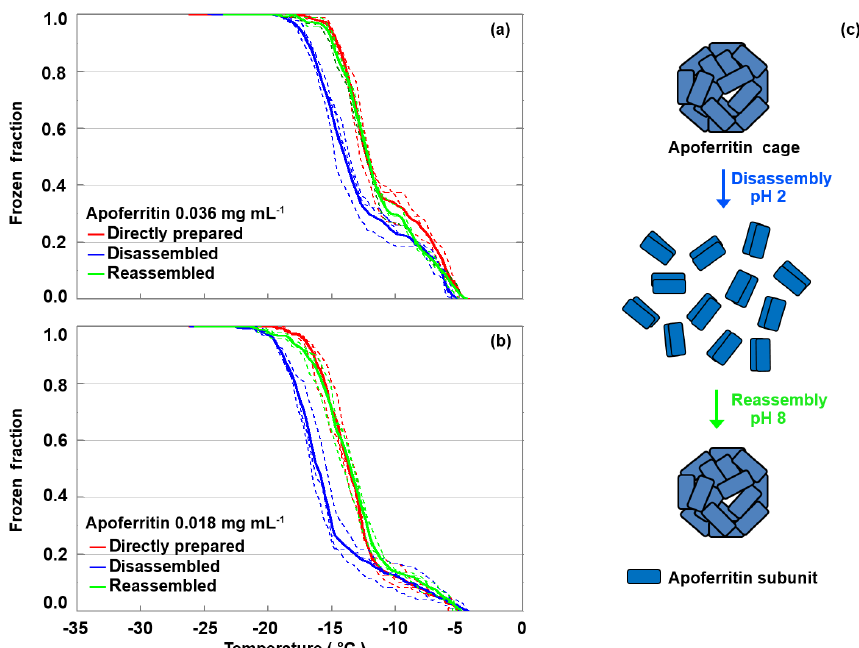
Figure 9. Disassembly and reassembly experiment performed with apoferritin (batch 2) at 0.036mgmL − 1 (a) and 0.018mgmL − 1 (b) . Frozen fractions are given for the directly prepared apoferritin, the disassembled apoferritin at pH 2, and the reassembled apoferritin at pH 8. (c) Schematic illustration of the disassembly and reassembly process: at pH 2 apoferritin undergoes disassembly into rod-like subunit dimers, and increasing pH to 8 restores the fully assembled apoferritin